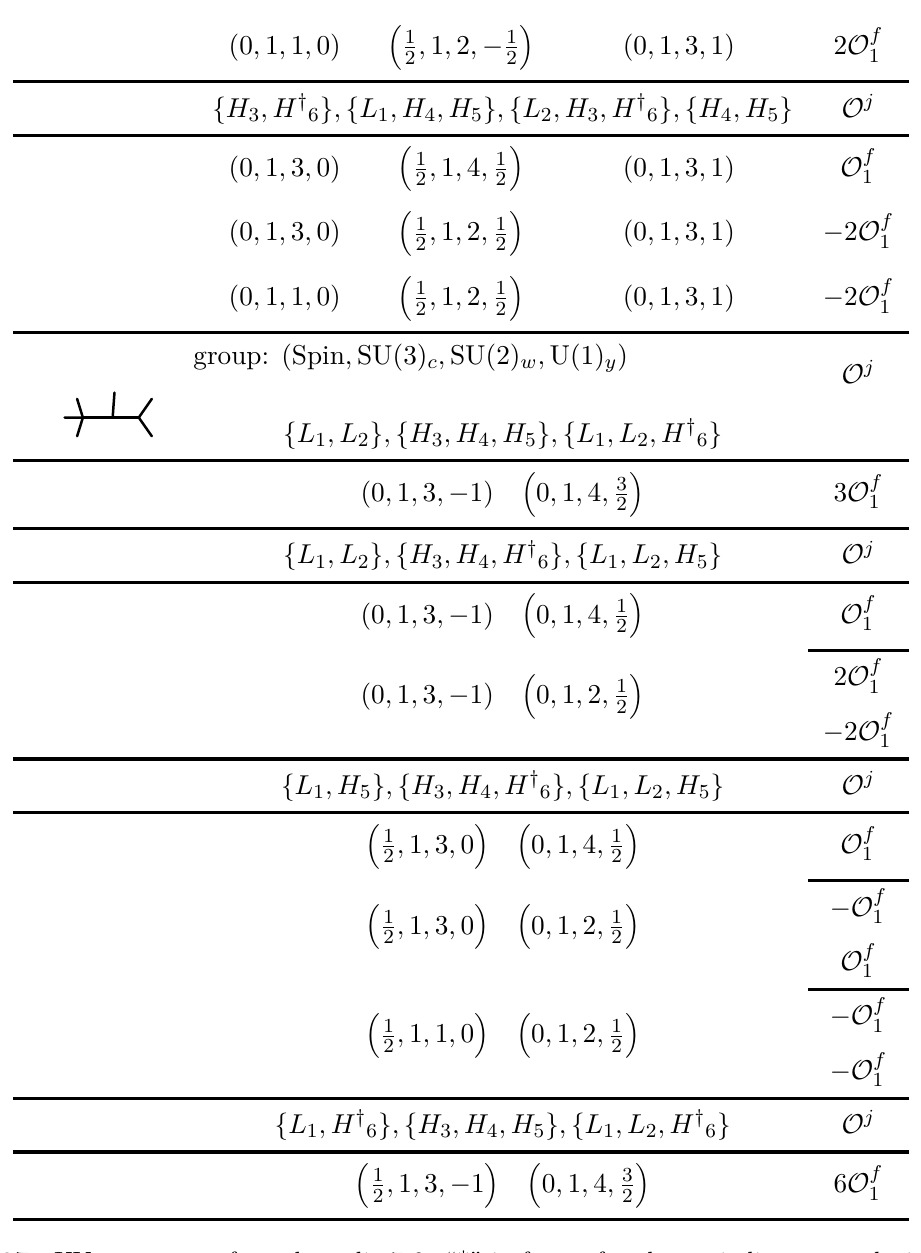
Table 27. UV resonance of topology dim7-6. “*” in front of each row indicates topologies with nonrenormalizable vertices. The UV resonances colored in gray are eliminated by UV